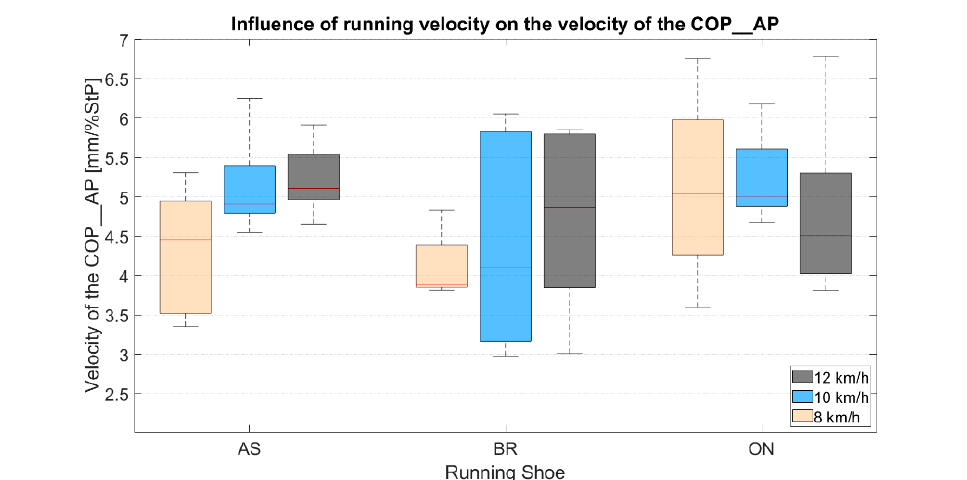
Figure 2. Results for the influence of the three running velocities on the peak velocity of the center of pressure movement in the anterior-posterior direction (COP_AP) during the first 30% of the stance phase (StP) for all three tested running shoes. The horizontal axis lists the three running shoes (AS— Asics, BR—Brooks, ON—On), and the vertical axis shows the “ride” in mm per % of the StP. The bright flesh-colored boxes represent the lowest running velocity (8 km/h), the blue boxes represent the medium running velocity (10 km/h), and the dark grey boxes represent the highest running velocity (12 km/h).